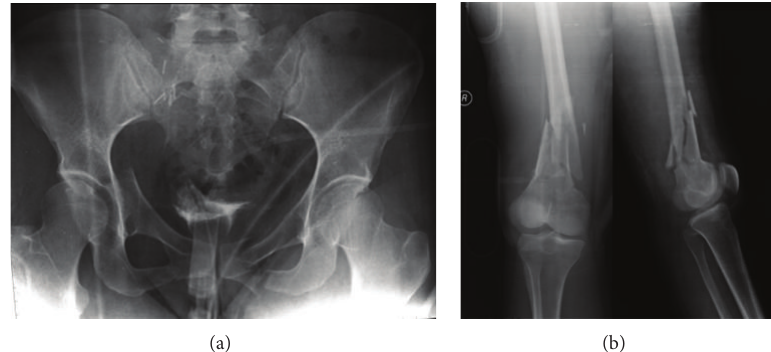
Figure 1: X-ray in the emergency room showing (a) the right-sided anterior column and the left-sided pubic rami fractures of acetabulum. (b) The right-sided distal femoral metaphyseal complex (OTA 33-D3) fracture.